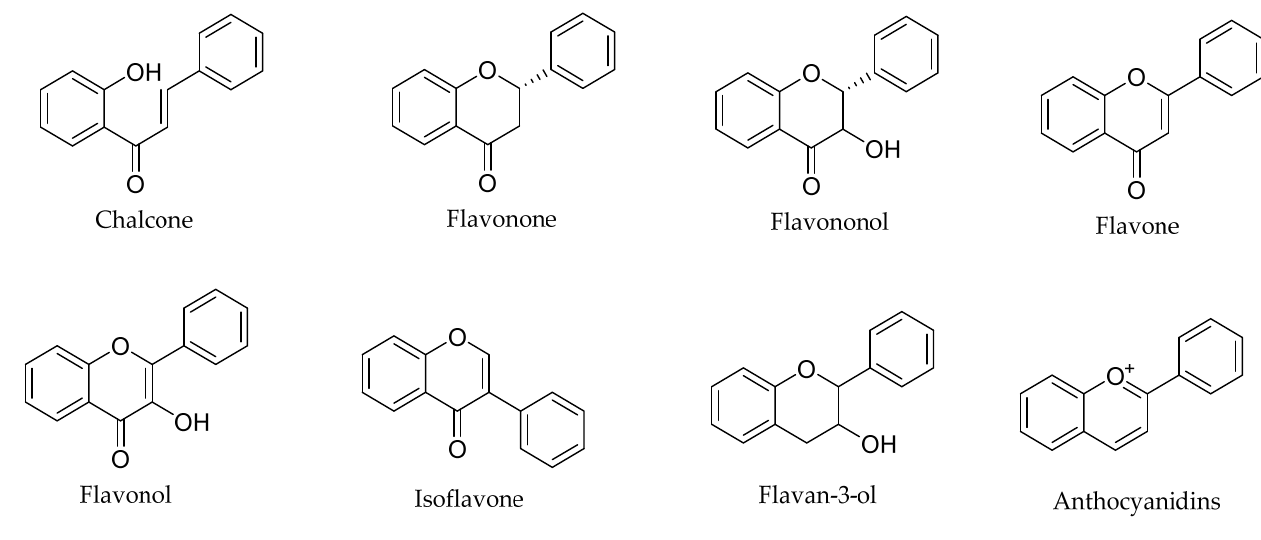
Figure 1. Various classes of flavonoids.